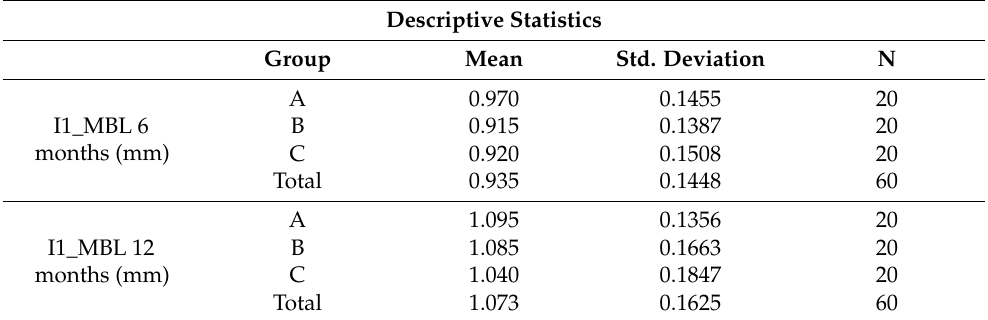
Table 5. Average marginal bone loss (millimeters) of mesial implants (I1) observed during